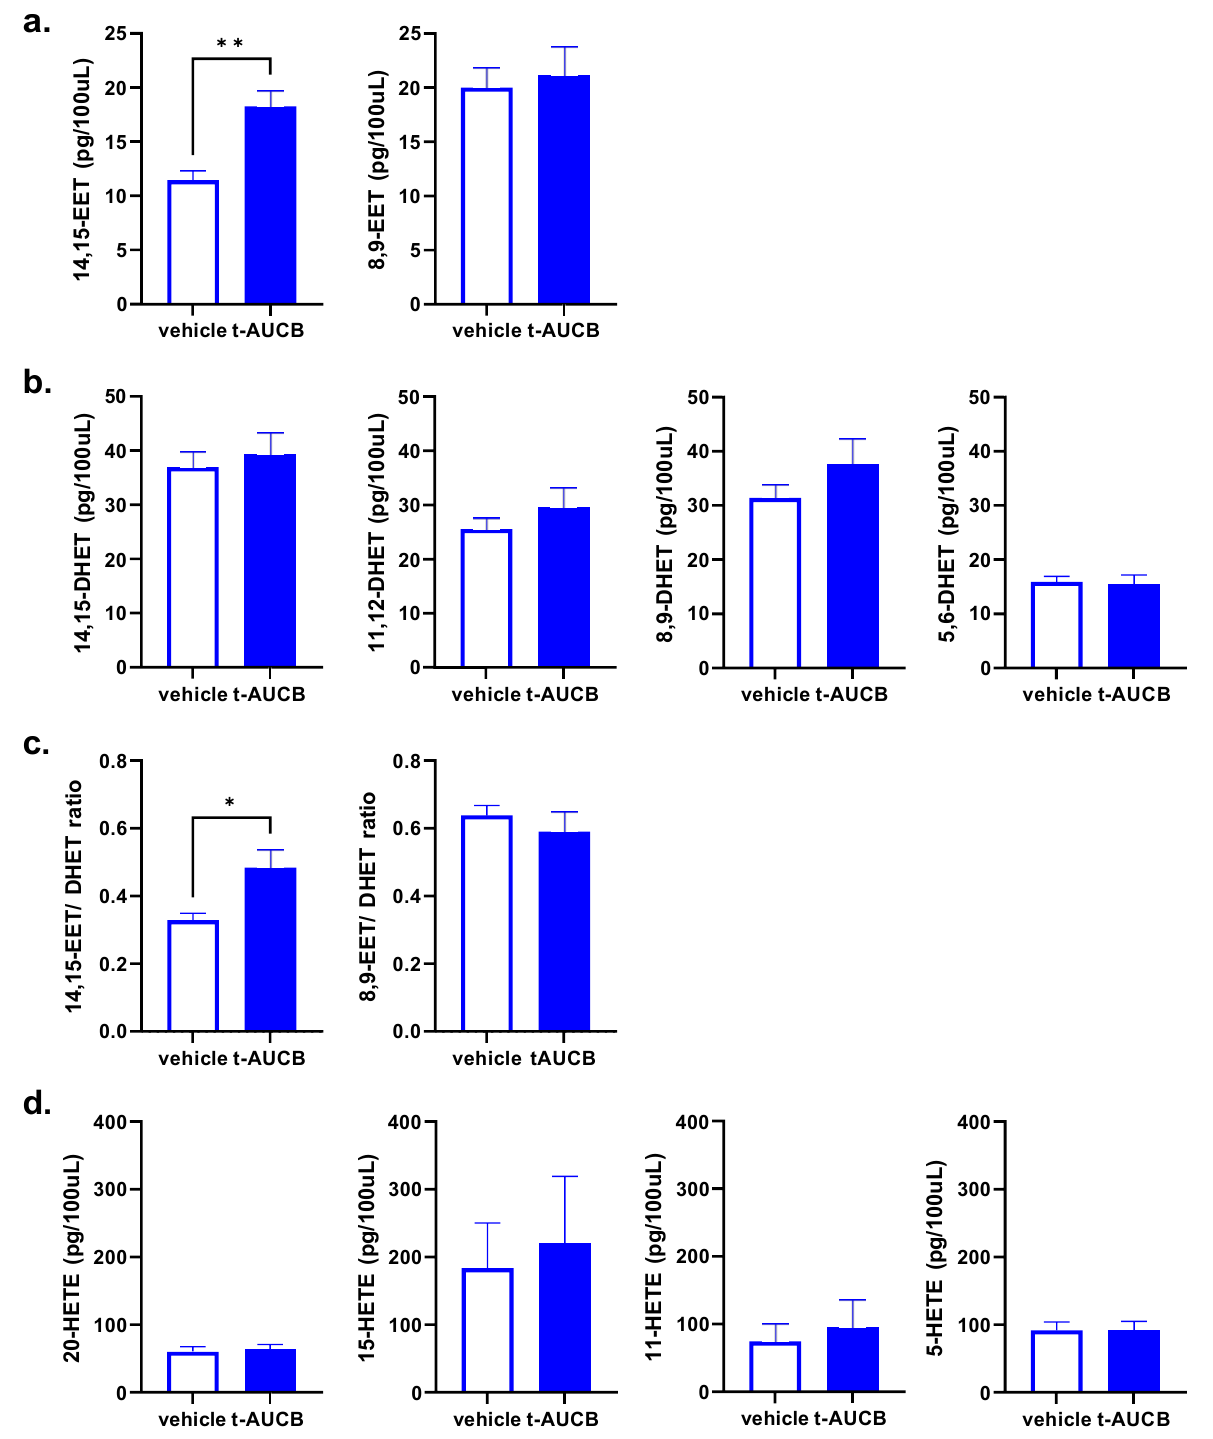
Figure 4. tAUCB selectively increases plasma 14,15-EET and 14,15-EET:DHET ratio in diabetic mice. Plasma concentrations of ( a ) EET, ( b ) DHET, ( c ) EET:DHET ratio and ( d ) HETE regioisomers assessed by LC-MS/MS 24 h following tAUCB administration and MCAO. Plasma 14,15-EET concentration and 14,15-EET:DHET ratio, are elevated in the tAUCB group compared to vehicle (** p < 0.01, * p < 0.05, n = 7–8/group).